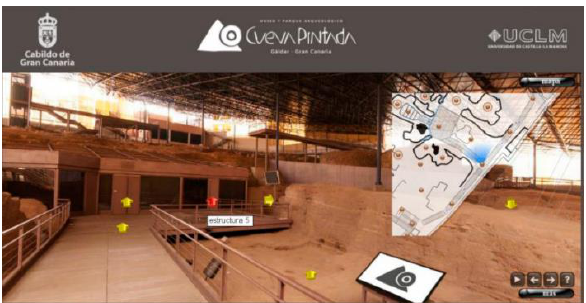
Figure 12. Virtual end visit of the Cave Painted archaeological site